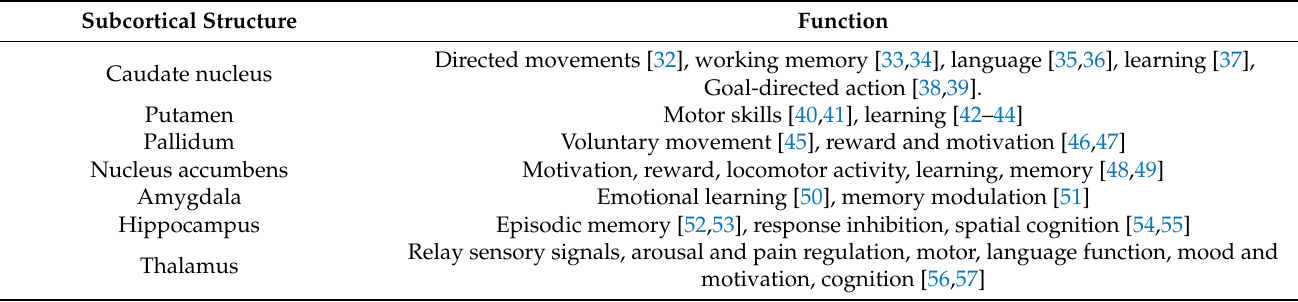
Table 1. Subcortical structures and